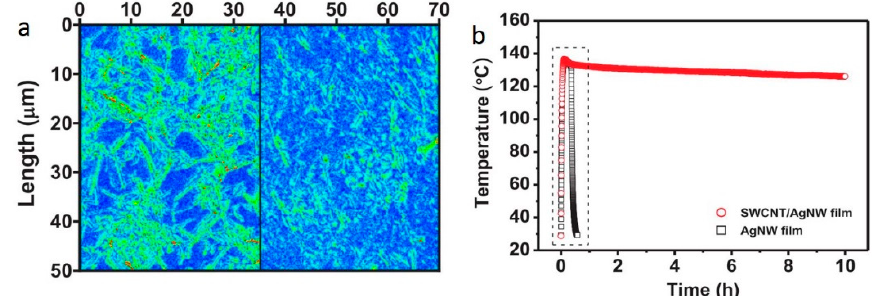
Figure 9. ( a ) Thermo reflectance images of the AgNW (left) and SWCNT/AgNW (right) films, ( b ) Temperature–time curves of the AgNW and SWCNT / AgNW heaters. Reprinted with permission from [98]; Copyright 2020 Elsevier.